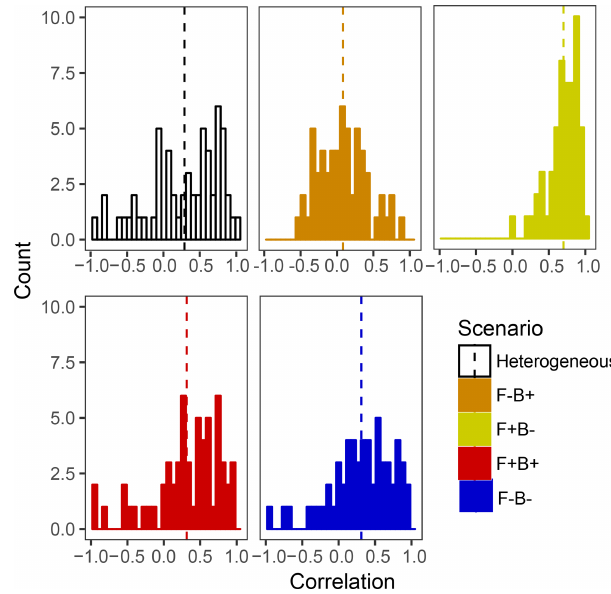
Figure 6. Frequency histograms of Pearson correlation coefficients between the number of enzymes taxa which survive to the end of the 6000d run and their C t . Each panel corresponds to a different scenario shown elsewhere in the paper, with the counts in each bar corresponding to a single starting seed (community) under that sce- nario. Vertical lines denote the mean correlation coefficient for the